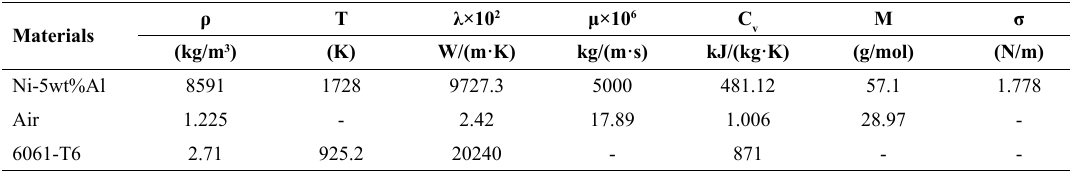
Table 1. Thermo physical parameters for numerical analysis. Materials